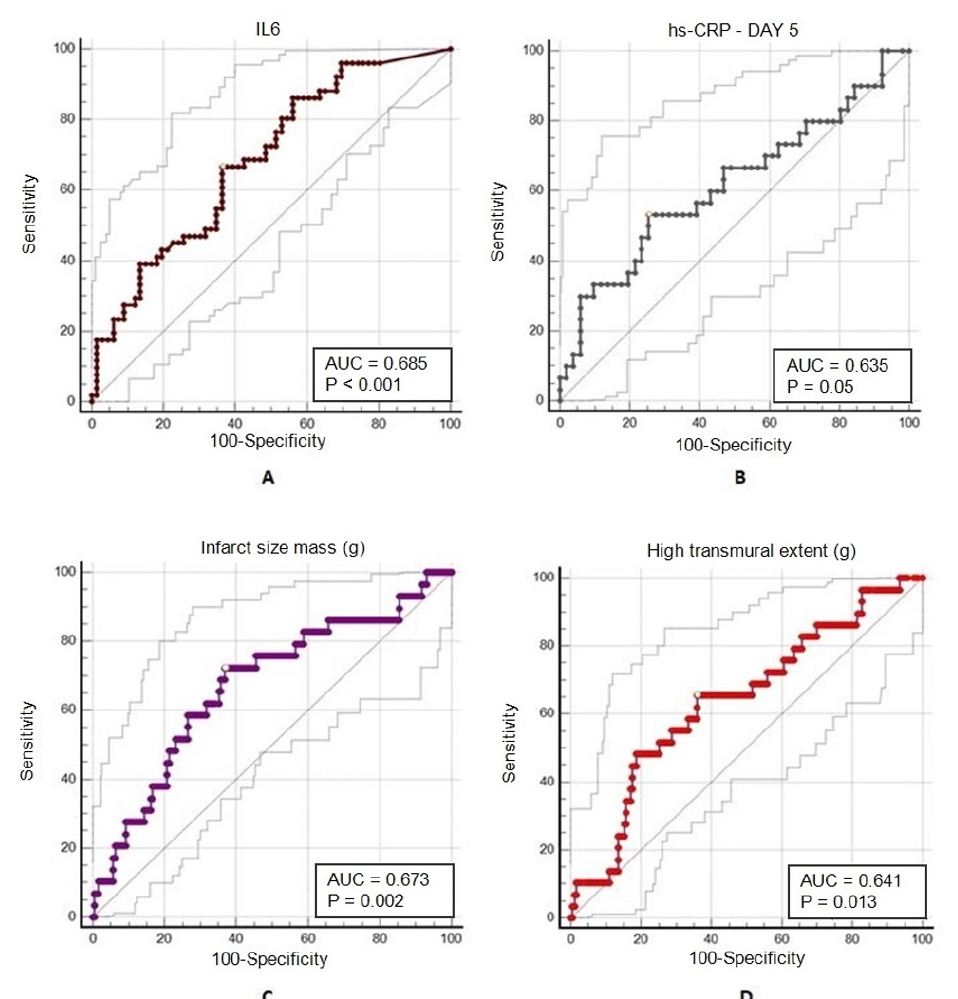
Figure 3. ROC curve analyses: prediction of infarct size based on ( A ) IL-6 and ( B ) day-5 hs-CRP; prediction of 2-year mortality based on CMR parameters ( C ) infarct size and ( D ) high transmural extent of the scar tissue. Table 7. Multivariable logistic analysis for prediction of IS and 2-year